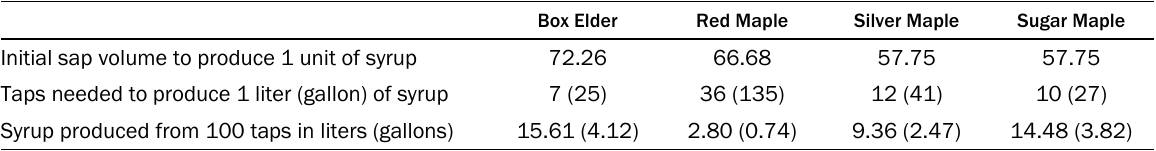
Table 5. Potential Capacity for Syrup Production by Species